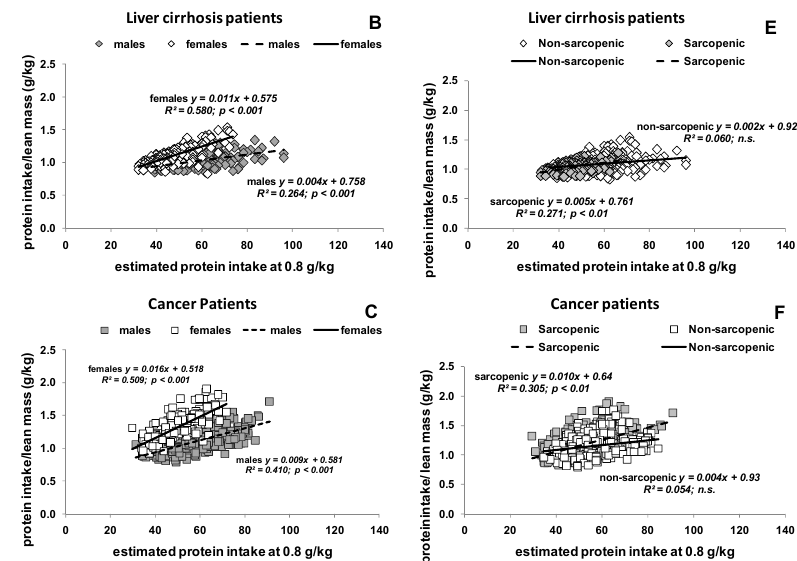
Figure 2. Relationship between estimated (body weight based) protein intake at 0.8 g protein per kilogram body weight (g/kg) and the ratio of protein intake (g) divided by lean mass (kg) in healthy subjects, patients with liver cirrhosis and cancer. The relationship is shown stratified by: sex ( A – C ); and sarcopenic phenotypes ( D – F ) (solid line and broken line show the corresponding regression line). Lean mass was measured as lean soft tissue by DXA in healthy subjects, fat free mass by bioelectrical impedance in cirrhotic patients and by computer tomography in cancer patients.